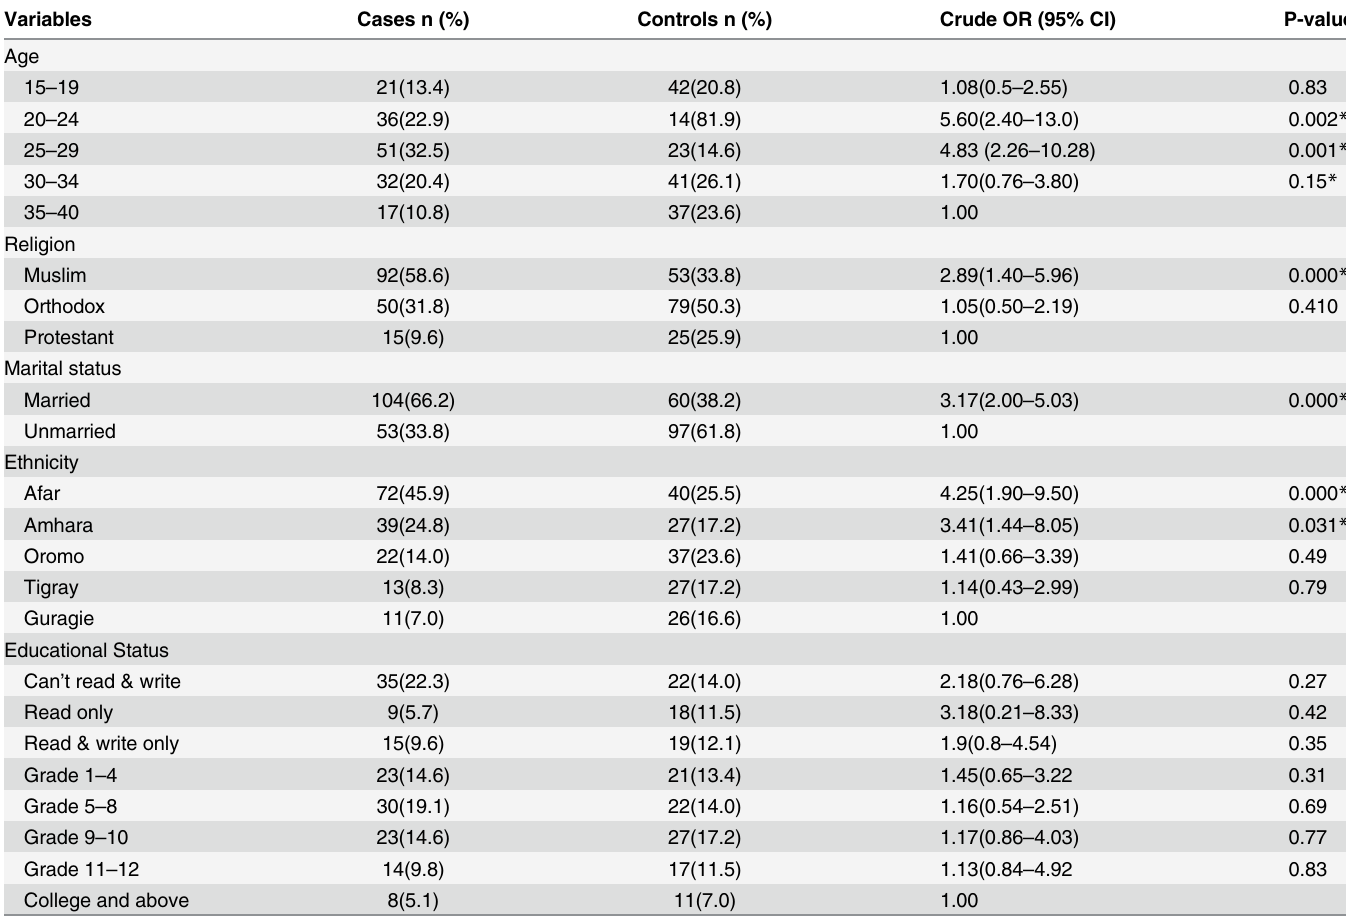
Table 1. Socio-demographic characteristics of cases and controls among HIV positive on ART women, Afar, Ethiopia,